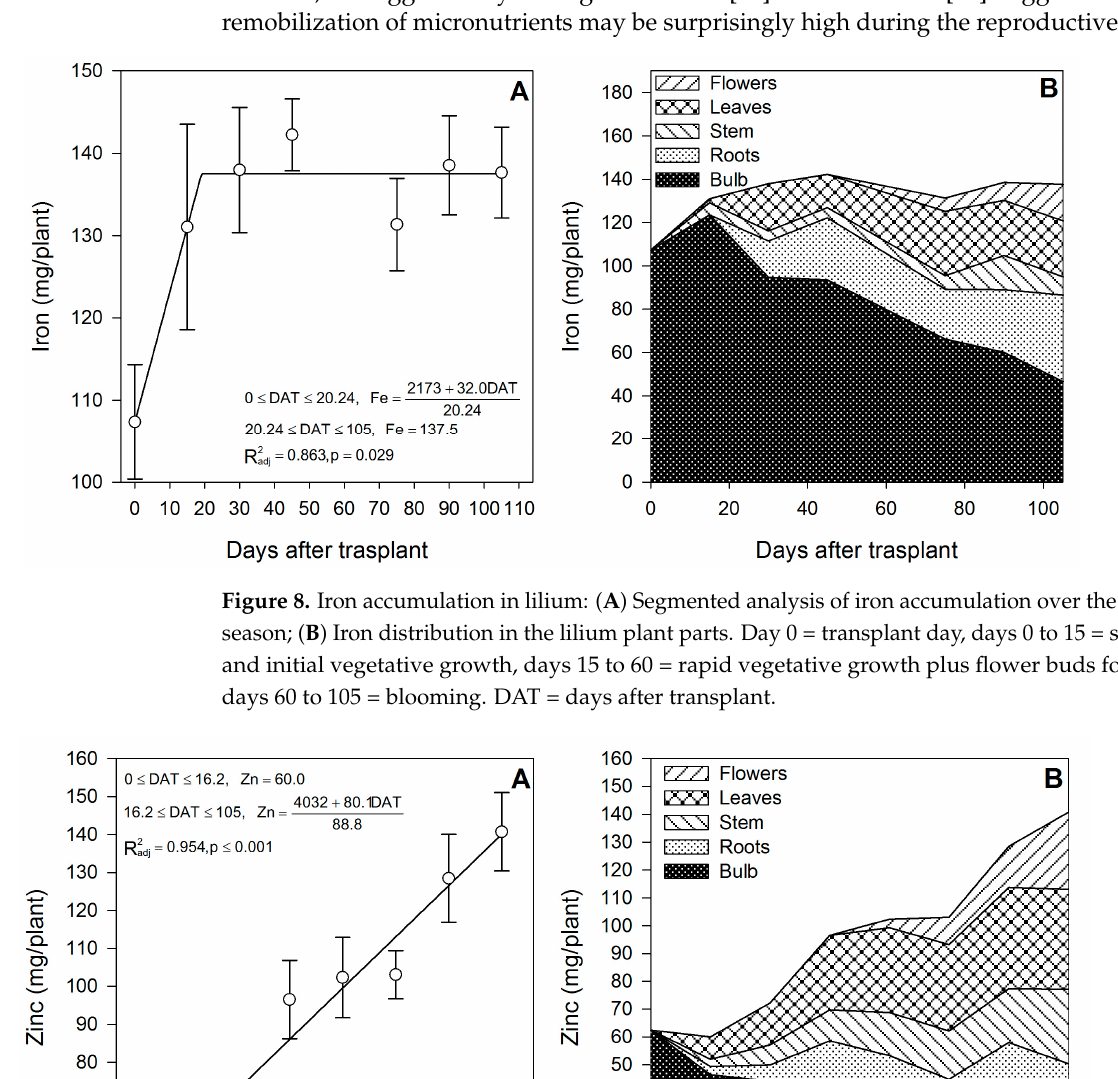
Figure 10. Manganese accumulation in lilium: ( A ) Segmented analysis of manganese accumulation over the growing season; ( B ) Manganese distribution in the lilium plant parts. Day 0 = transplant day, days 0 to 15 = sprouting and initial vegetative growth, days 15 to 60 = rapid vegetative growth plus fl ower buds formation, days 60 to 105 = blooming. DAT = days after transplant.